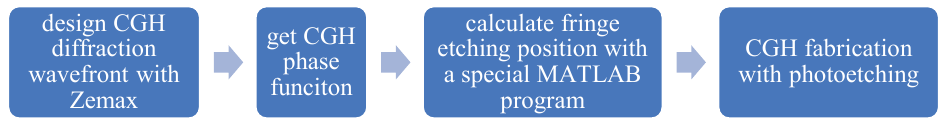
Figure 3. CGH design process.